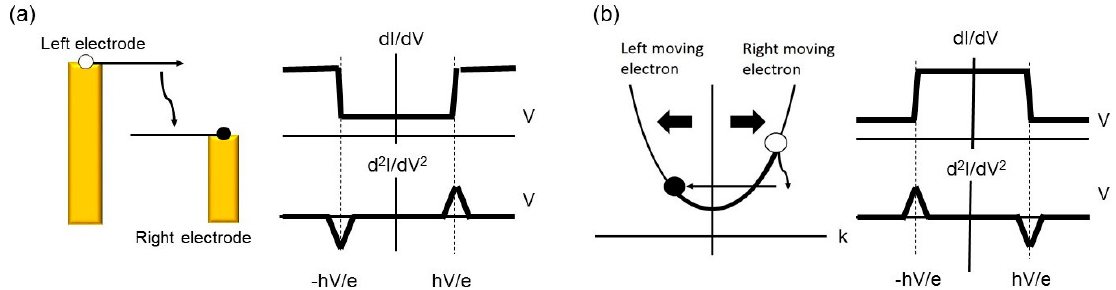
Figure 3. ( a ) Schematic image of inelastic electron tunneling spectroscopy (IETS). The excitation of a vibrational mode by conduction electrons opens an additional inelastic channel together with the elastic channel. Above a threshold voltage ( V = h ν / e ), the conductance increases, and peaks are observed in d 2 I / dV 2 curve. ( b ) Point contact spectroscopy (PCS): The electrons moving the right direction are scattered backwards by the vibrational mode excitation. Above the threshold voltage, the conductance decreases, and dips are observed in d 2 I / dV 2 curve.